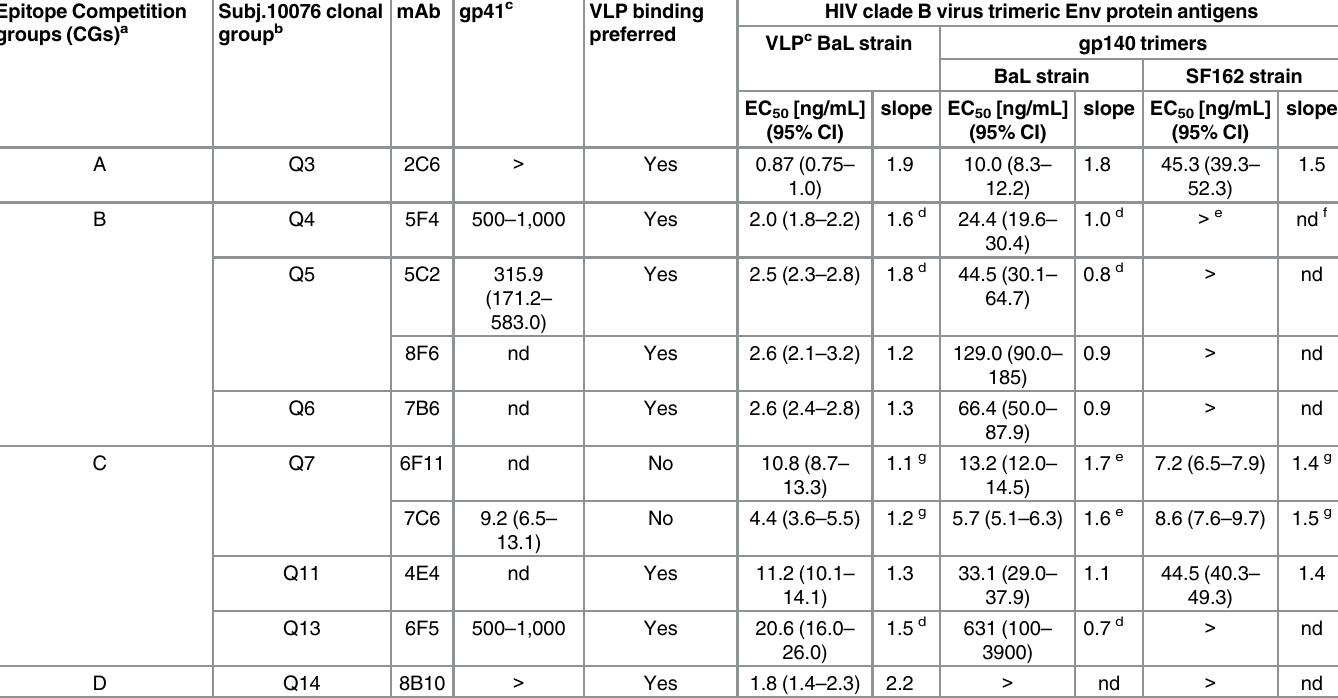
Table 1. Epitope competition group (CG) assignment, binding kinetics and preference of quaternary-epitope targeting Abs for binding to Env in VLPs gp140 trimers. Epitope Competition groups (CGs)